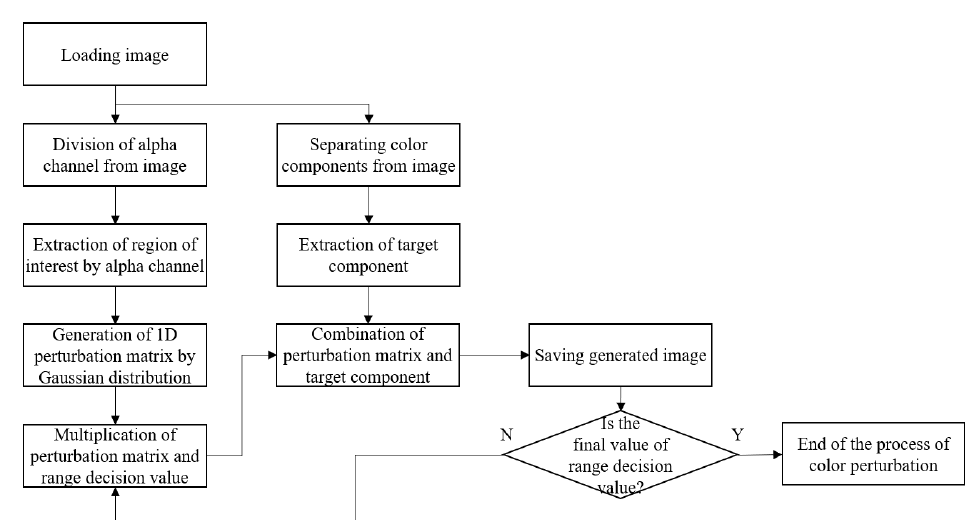
Figure 7. Process of color perturbation for components of color